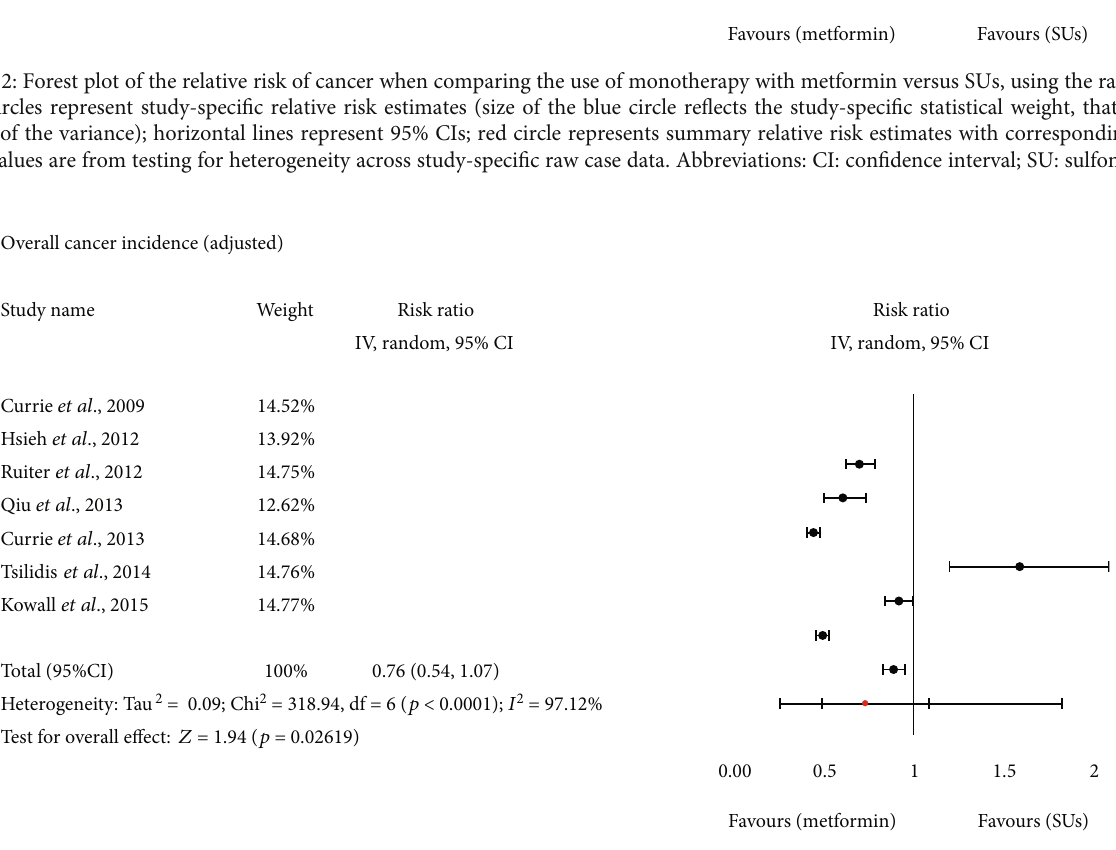
Figure 3: Forest plot of study-speci fi c relative risk estimates (adjusted) overall cancer incidence monotherapy with metformin versus SUs. Black circles represent study-speci fi c relative risk estimates (size of the black circle re fl ects the study-speci fi c statistical weight, that is, the inverse of the variance); horizontal lines represent 95% CIs; red circle represents summary relative risk estimates with corresponding 95% CIs; p values are from testing for heterogeneity across study-speci fi c raw case data. Abbreviations: CI: con fi dence interval; SU: